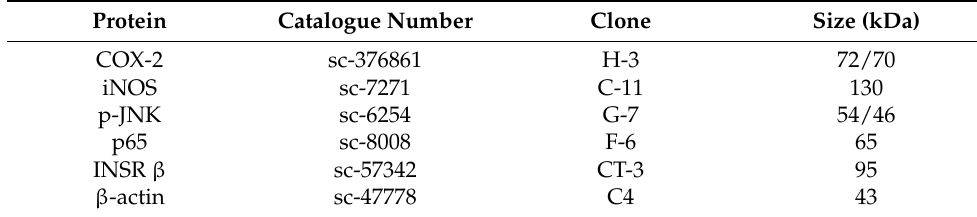
Table 2. Primary antibodies employed in Western blot